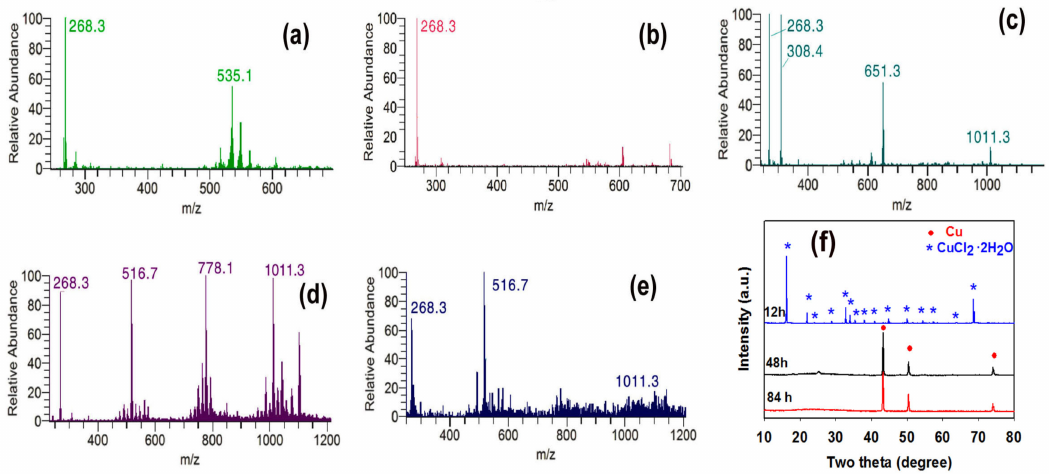
Figure 3. Mass spectra of oleylamine ( a ) and reaction mixtures after different reaction times: ( b ) 0 h (namely blue emulsion), ( c ) 12 h, ( d ) 48 h, and ( e ) 84 h; ( f ) XRD patterns of the product formed at different reaction